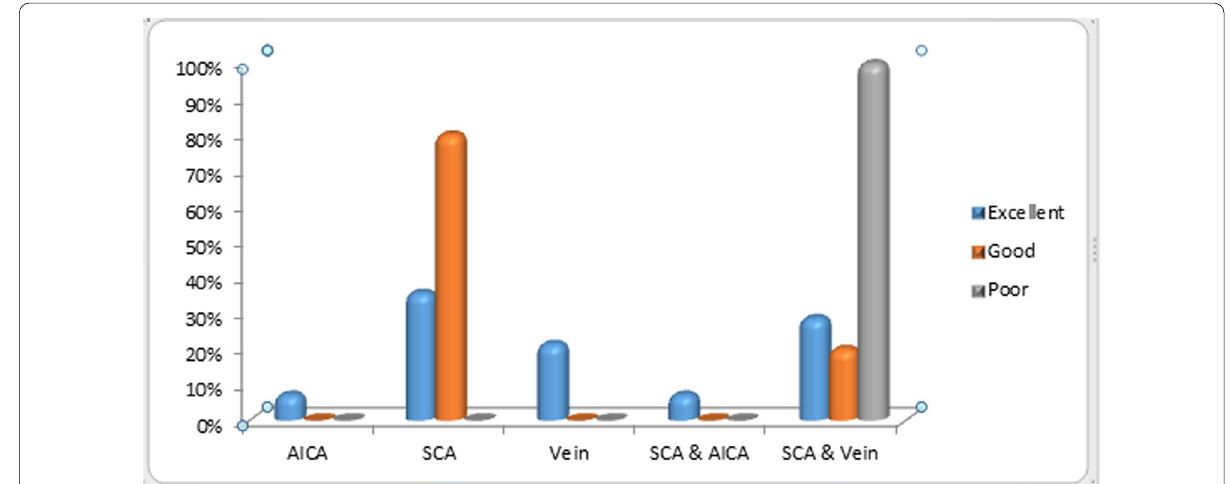
Fig. 1 Overall results of 20 cases of MTN according to causes of TN